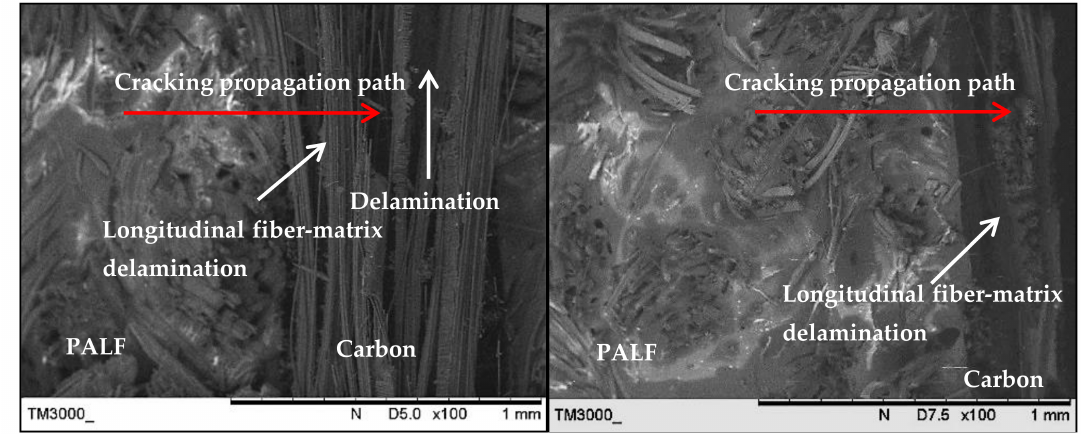
Figure 11. Scanning electron microscopy images of the laminate with a carbon ply interior (PCCP) and ply orientation [ ± 45 ◦ n , 0 ◦ n , 90 ◦ n ] s and the laminate with a carbon ply exterior (CPPC) and ply orientation [0 ◦ n , 90 ◦ n , ± 45 ◦ n ] s